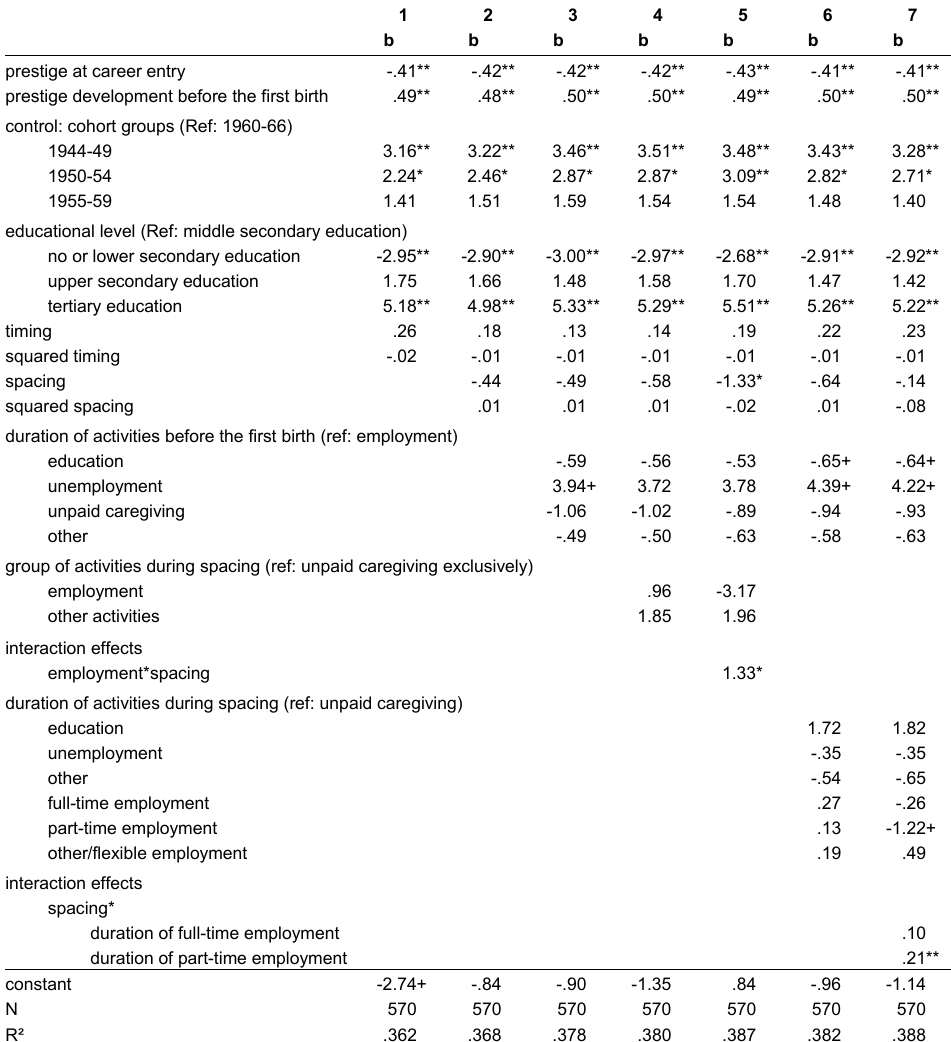
Table 6 : impact of timing, spacing, and the related activities on prestige at age